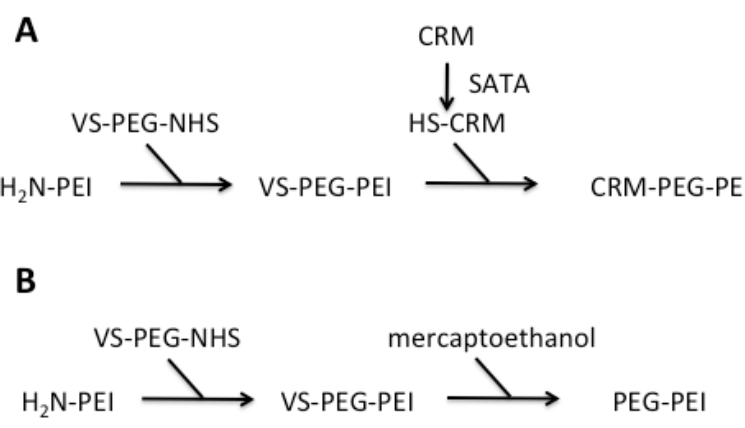
Figure 1. Schematic representation of the synthesis of PEI-conjugates. PEI F25-LMW was conjugated with VS-PEG-PEI to the intermediate VS-PEG-PEI. This intermediate was either transformed into CRM197-PEG-PEI via conjugation to SATA-activated CRM197 ( A ) or quenched with mercaptoethanol to obtain PEG-PEI ( B